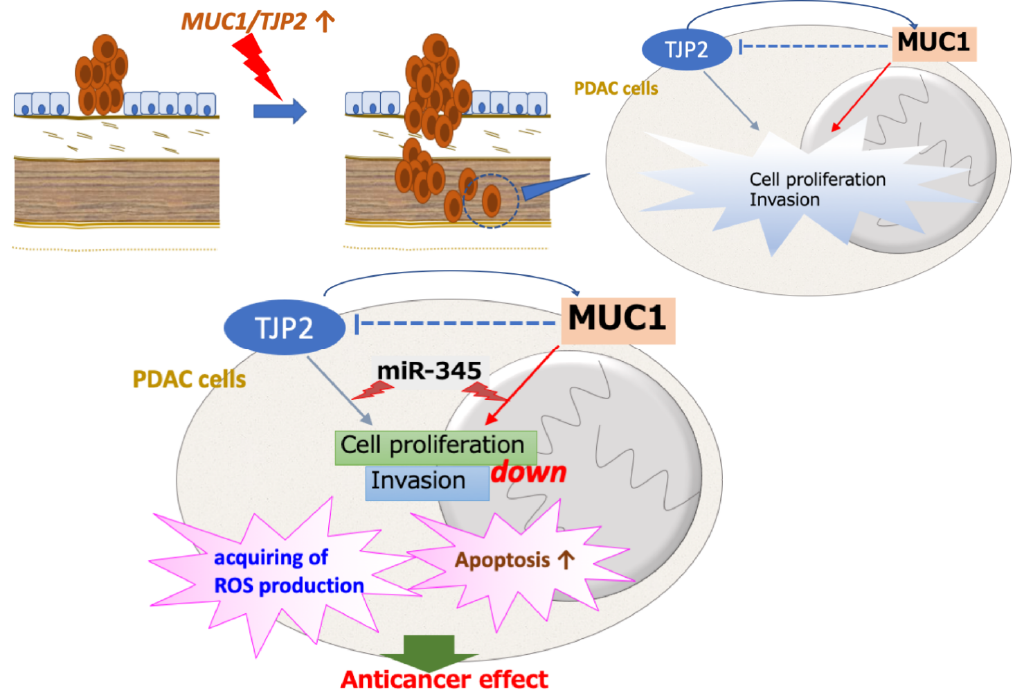
Figure 5. Function of MUC1 and TJP2 in PDAC (Panc0203 and Panc1 cells). MUC1 and TJP2 are putative target molecules of miR-345. miR-345 regulates cell proliferative and invasive potential and ROS production in PDAC.